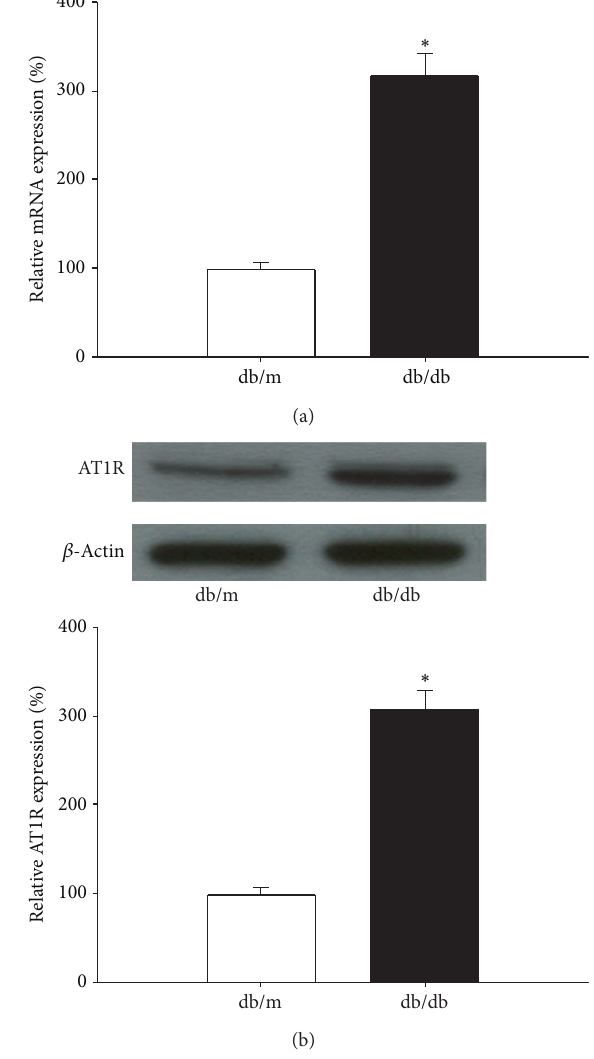
Figure 1: Expression in islet of AT1R in db/m mice and db/db mice. (a) Expression in islets of AT1R mRNA in db/m mice or db/dbmice.GeneexpressionwasmeasuredbyquantitativeRT-PCR. Graphical presentation shows the relative AT1R mRNA abundance after normalization to actin. Data are presented as mean ± SD, ∗ 𝑃 < 0.05 versus db/m group, 𝑛 = 5 . (b) Expression of AT1R protein in islets from db/m mice or db/db mice. Lysates from freshly isolated islets were analyzed for AT1R expression by western blot analysis. Results represent the mean ± SD. Blots from one representative experiments are shown. ∗ 𝑃 < 0.05 versus db/m group, 𝑛 = 5